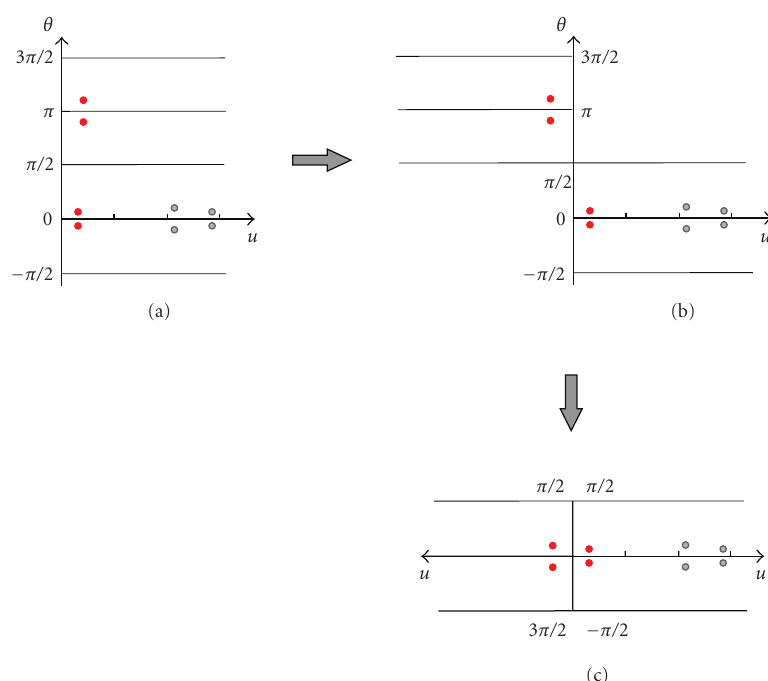
Figure 9: Two consecutive reflections that can be computed with FFT account for the global retinotopy without the foveal region.